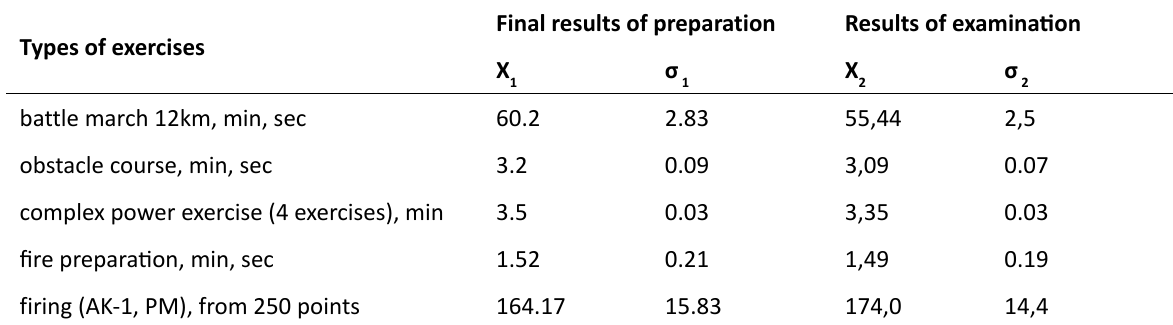
Table 3. Results of servicemen who passed the qualification examination for the right to wear the beret with honors Types of